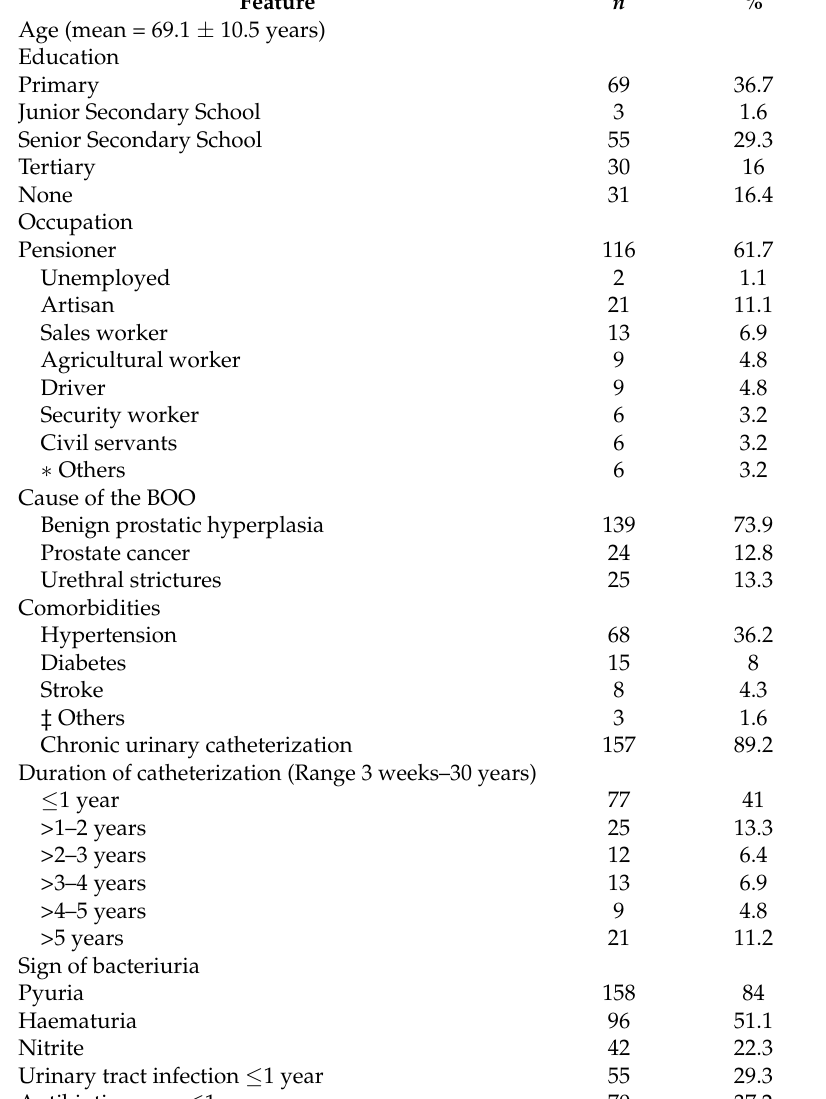
Table 1. The demographic and clinical features of the study